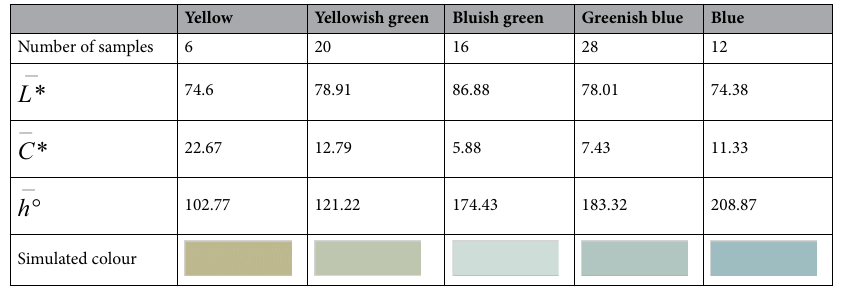
Table 3. The five average centres of K-Means clustering.